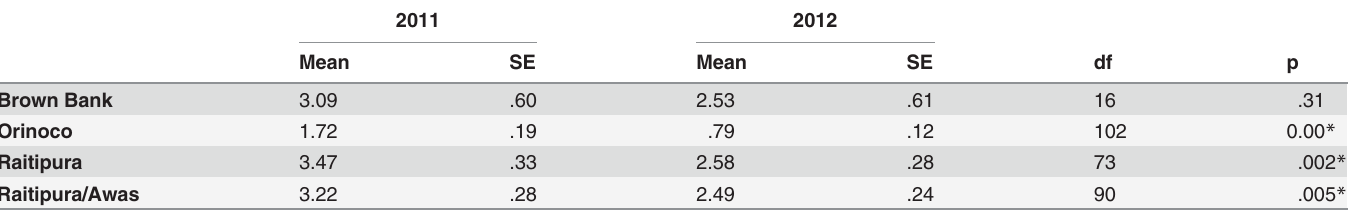
Table 1. Results of t-test of change in individual enforcement actions between 2011 and 2012 in four communities of the Pearl Lagoon basin.